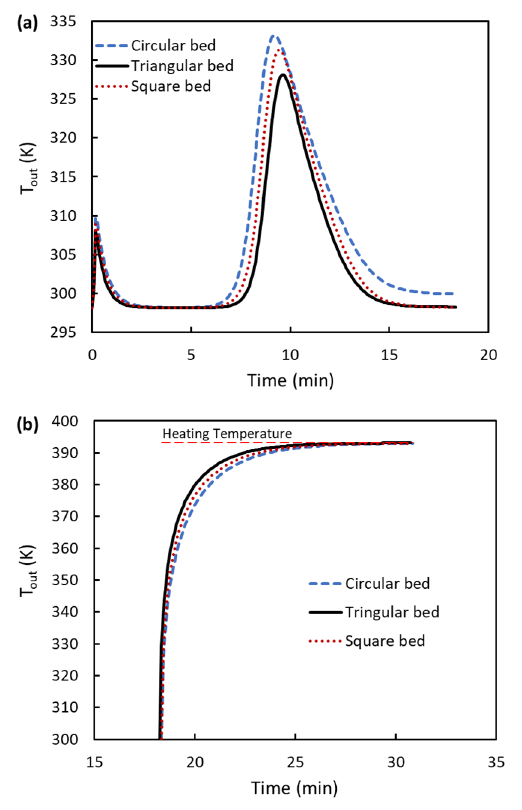
Figure 7. Temperature profiles during ( a ) adsorption process and ( b ) desorption process for the investigated beds.